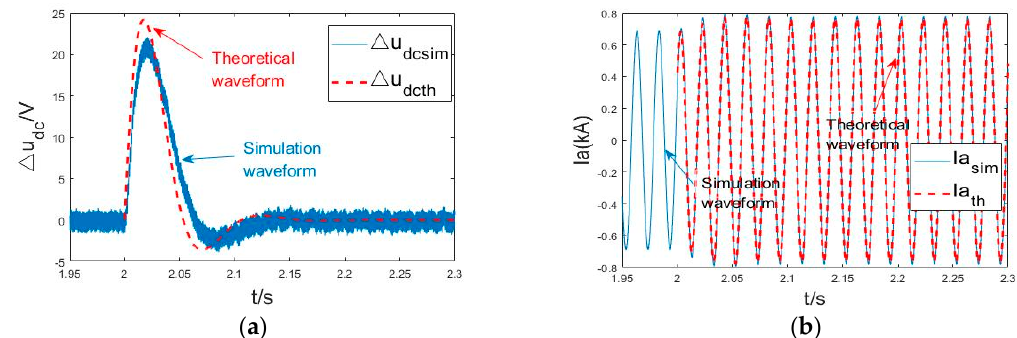
Figure 10. ( a ) Waveforms of bus voltage fault component. ( b ) Waveforms of phase-A output current.